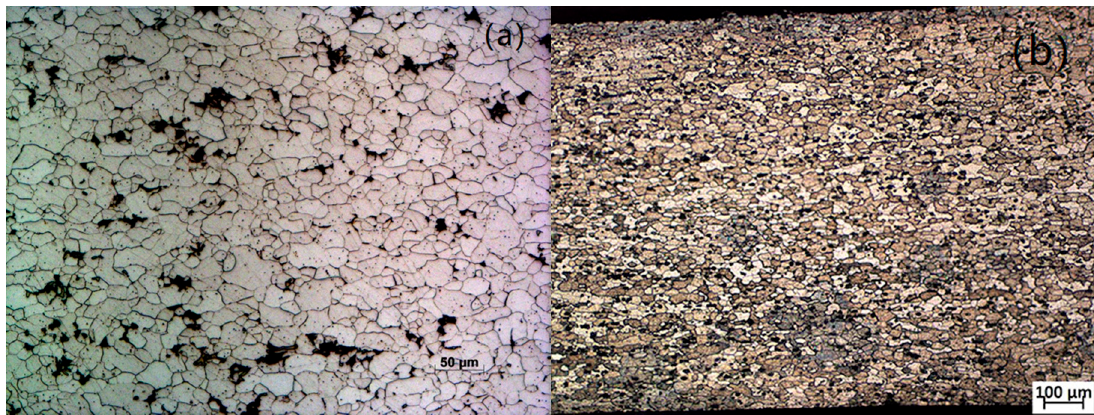
Figure 2. ( a ) Microstructure of the hot-dip galvanized steel sheet, and ( b ) microstructure of the 6061-T6 alloy.